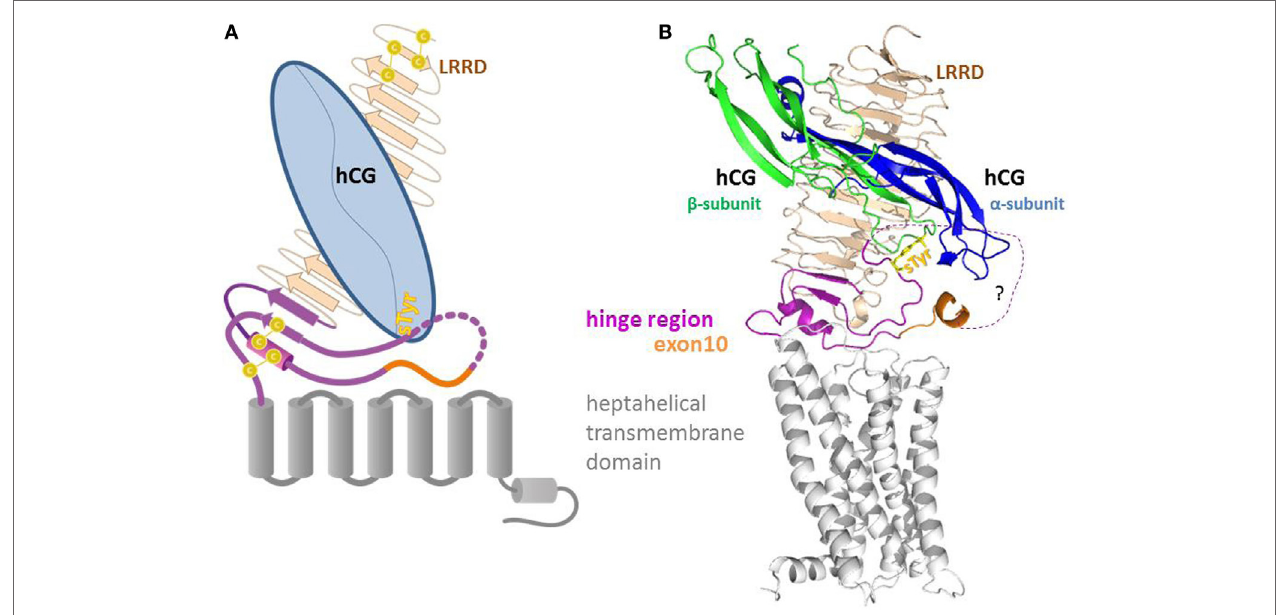
FigUre 1 | sketch (a) and homology model (B) of the full length lhcg-receptor with heterodimeric hormone ( α and β subunit) bound to the extracellular leucine-rich-repeat domain (lrrD) and the hinge region . The hinge region that harbors exon10 and the second hormone binding site (sTyr) provides a structural and functional link between the LRRD and the heptahelical transmembrane